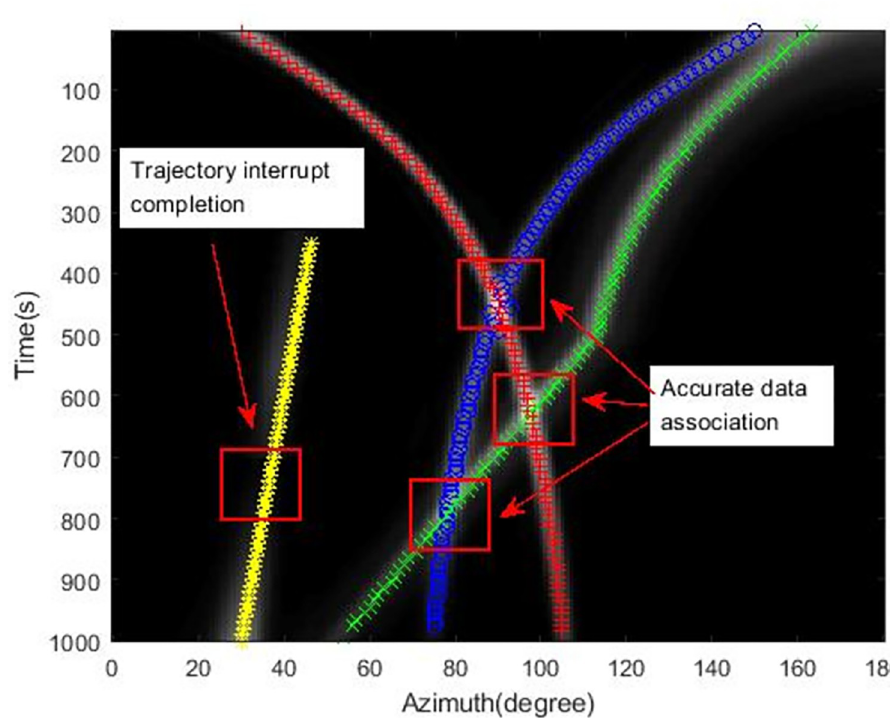
Fig 12. Simulation tracking results of the MLDE method.